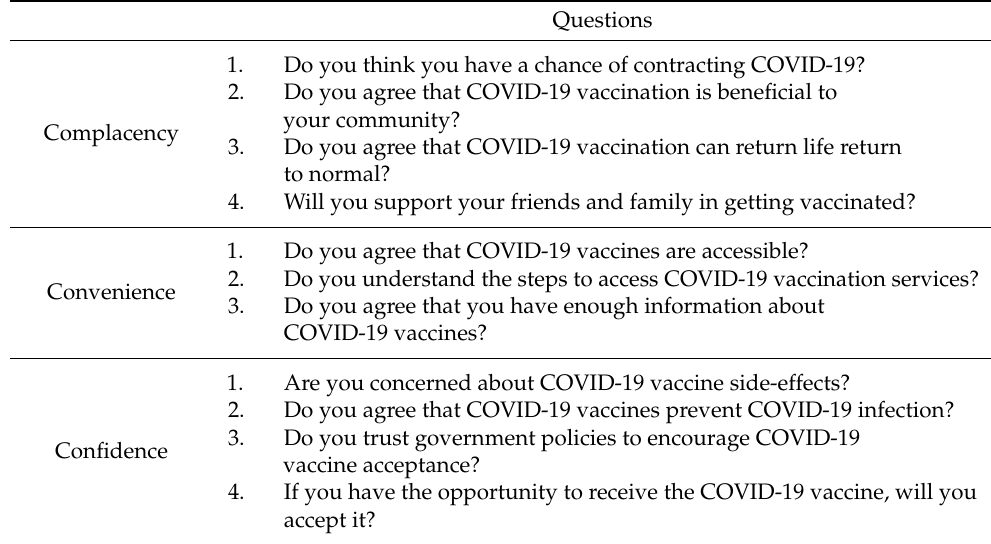
Table 1. Determinants of COVID-19 vaccine